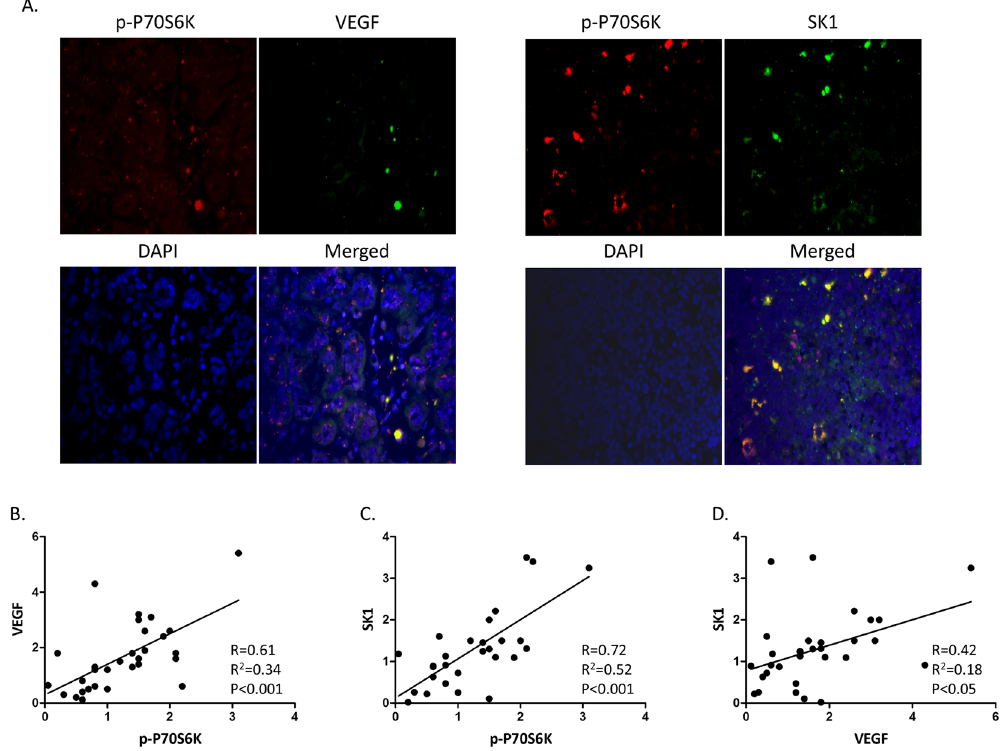
Figure 1. In oestrogen receptor (ER)-negative human breast tumours P70S6K phosphorylation correlates with SK1 and VEGF expression. Human breast tumours (n = 30) were stained with anti-SK1, anti-VEGF and anti-p-P70S6K antibodies. Tumour sections were immunostained as described in materials and methods and fluorescence was visualised using Zeiss Axioplan microscope and quantified using ImageJ software. ( A ) Representative immunofluorescence images of two different tumour sections. Correlation between VEGF and p-P70S6K ( B ) SK1 and p-P70S6K ( C ) and SK1 and VEGF ( D ) in FFPE human ER-negative breast tumours.